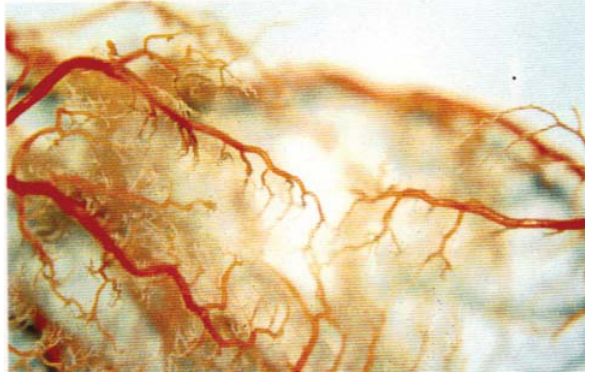
Fig. 5 - Anastomoses intercoronarianas. Observar ausência de anastomoses com a técnica